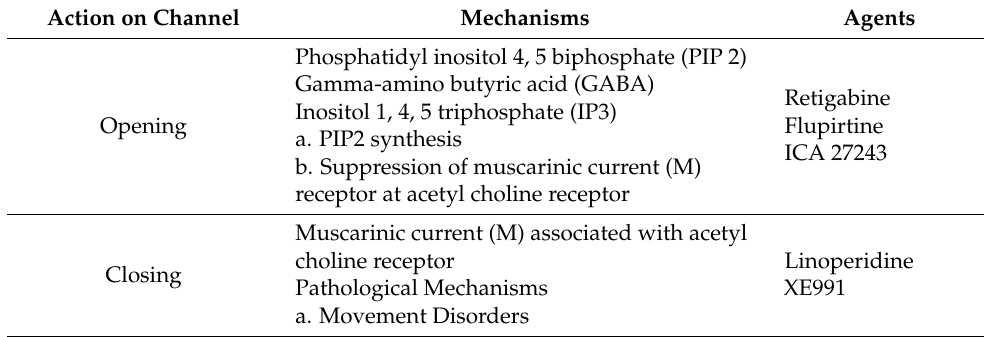
Table 2. Current Proposed Neuromodulation Tactics and Agents utilizing KCNQ